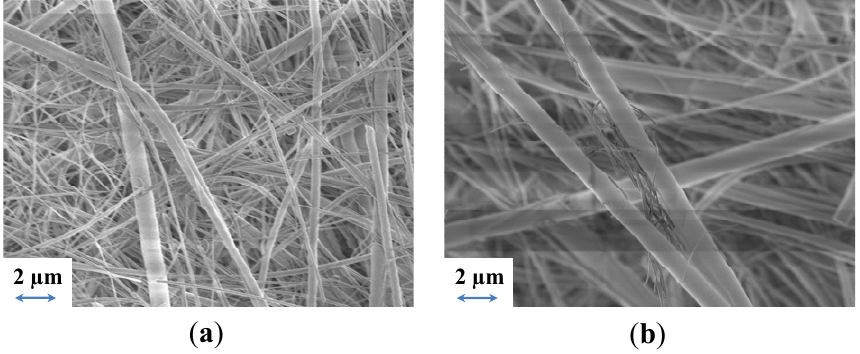
Figure 7. SEM micrographs of ( a ) Whatman GF-F and ( b ) GF-C separators.